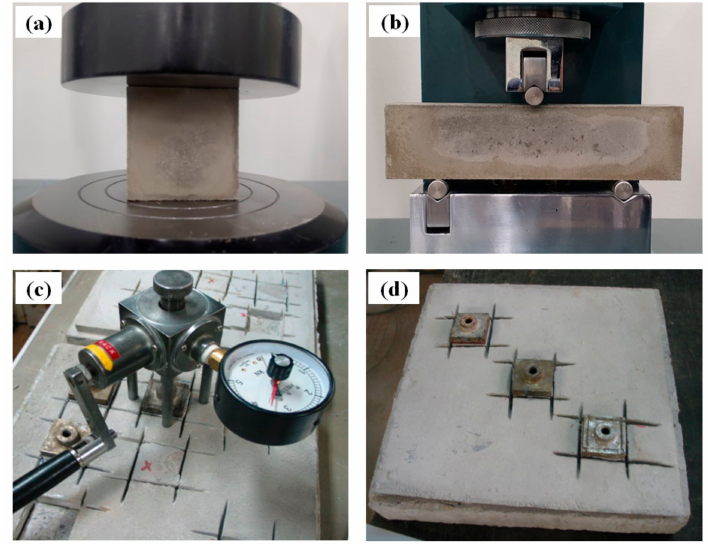
Figure 1. Mechanical test set-ups: ( a ) compressive test; ( b ) flexural test; ( c ) pull-o ff bond test; ( d ) attached dollies on the surface of the polymer-modified cement mortar (PCM) overlay.